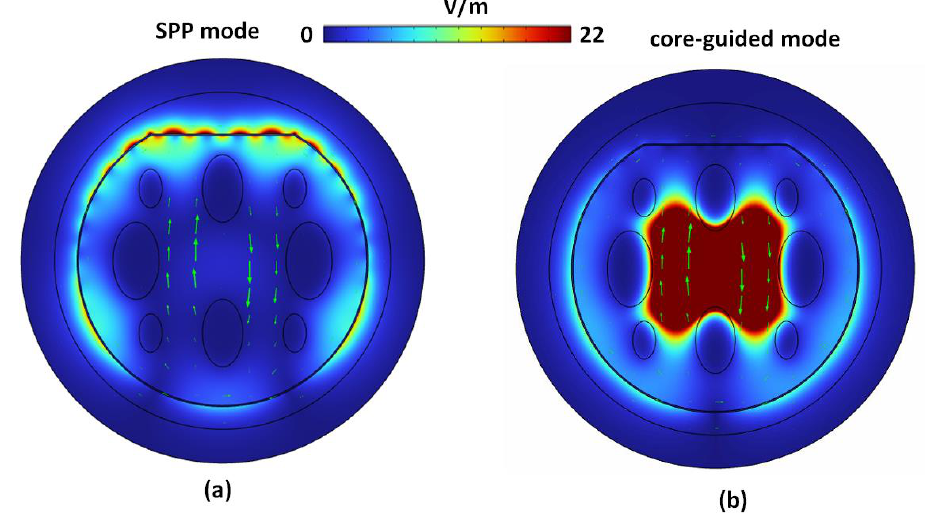
Figure 3. E-field distributions of the ( a ) SPP mode and ( b ) core-guided mode